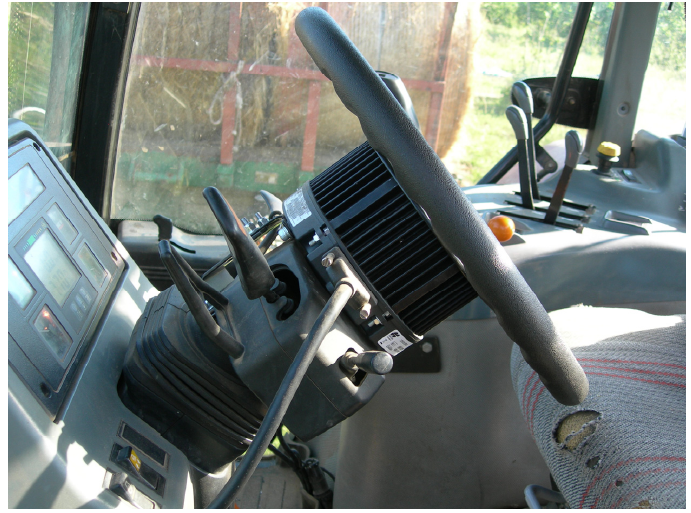
Figure 1. Steering wheel with automatic guidance device.